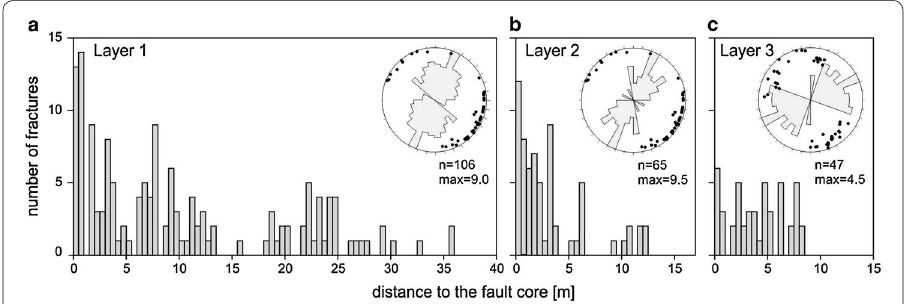
Fig. 7 Fracture orientation and intensity in Cleebourg, shown for three individual layers. In layers 1 and 2, the fracture orientations are comparable and the fracture intensity increases towards the fault core. In layer 3, fracture orientation and intensity show a different pattern. Rose diagrams with equal area scaling and 10° bin size and equal area pole point plots on the lower